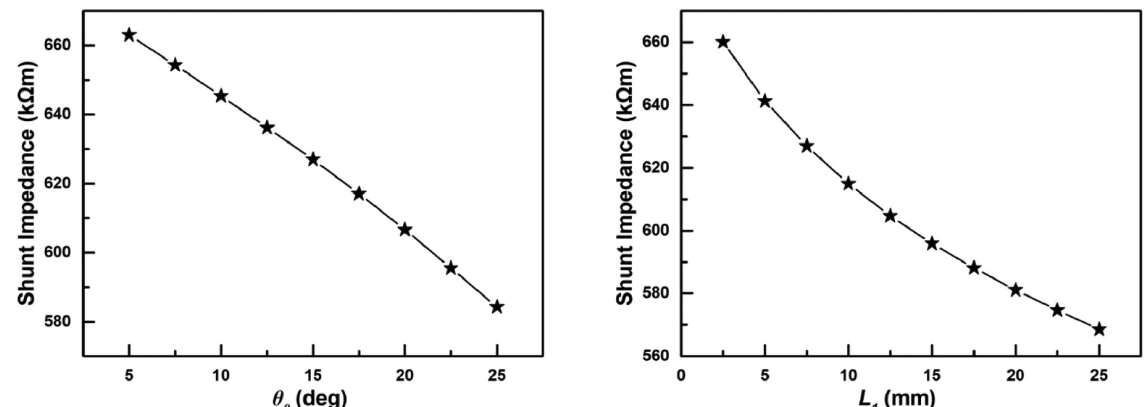
FIG. 5. Influences of θ 0 and L 1 on shunt impedance.